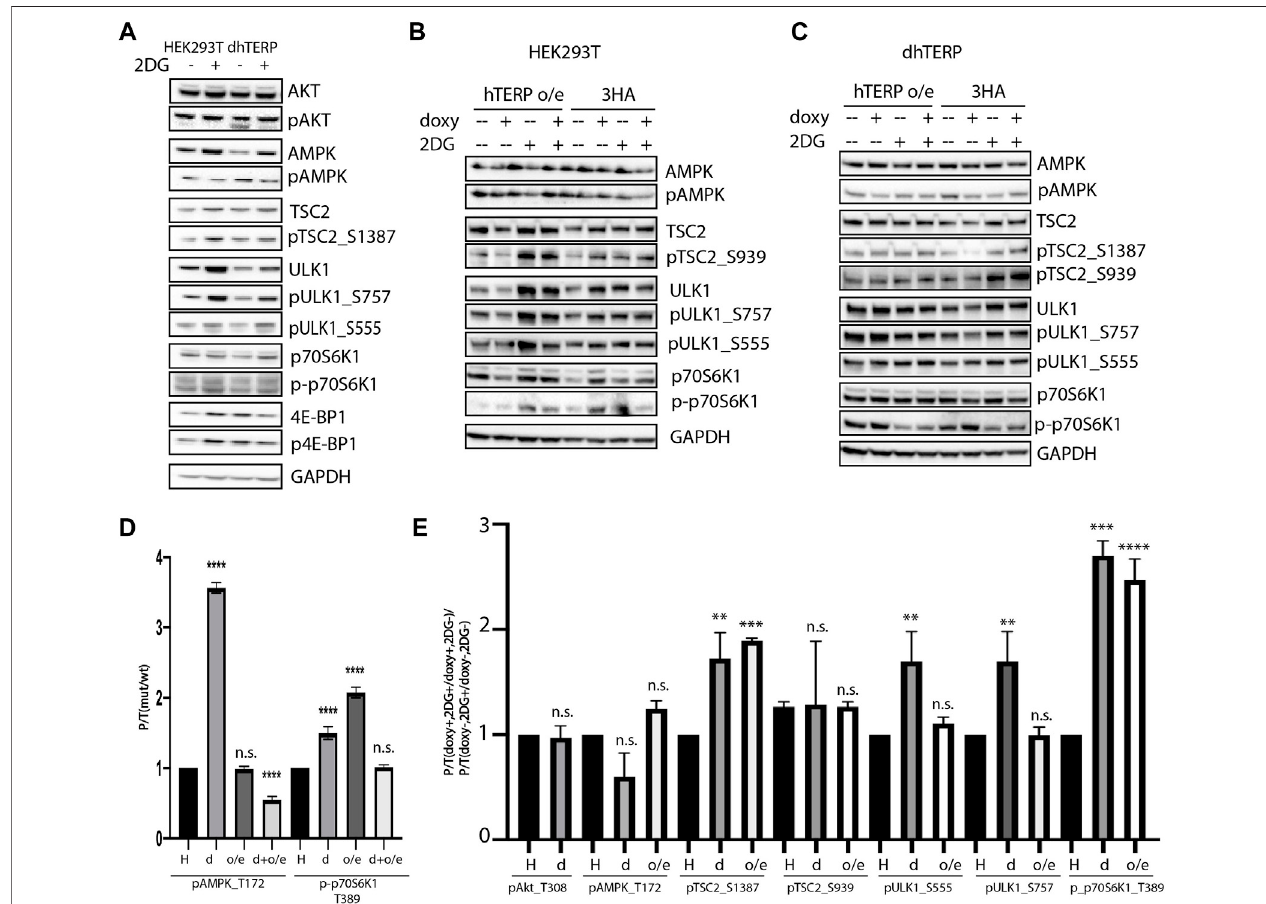
FIGURE 3 | hTERP modulates activity of kinases of relevant signaling pathways in HEK293T cells. (A) Lysates from wild-type and dhTERP HEK293T cells with or without 2 mM 2-deoxy-D-glucose (2DG) were probed with the indicated antibodies. (B,C) . Lysates prepared from wild-type HEK293T cells (B) and dhTERP HEK293T cells (C) exogenously expressing 3HA (HA) or hTERP-3HA (hTERP o/e) with or without 2 mM 2-DG were probed with the indicated antibodies. (D) Quanti fi cation of phosphorylation levels of the indicated proteins. Black bars correspond to the ratio of phosphorylated protein to total protein levels in wild-type HEK293T cells. Grey bars correspond to the ratio of phosphorylated protein to total protein level in dhTERP cells. Dark grey bars correspond to the ratio of phosphorylatedproteintototalprotein levelinoverexpressinghTERPHEK293Tcellstreatedwithdoxycycline.Lightgreybarscorrespondtotheratioofphosphorylated protein to total protein level in overexpressing hTERP dhTERP HEK293T cells treated with doxycycline. The ratio for modi fi ed cells was normalized to the ratio for wild type HEK293T cells from three independentwestern blots (mean ± SEM)and quanti fi ed using GraphPad software. **** p < 0.0001byDunett ’ smultiple comparison test. (E) Quanti fi cation of phosphorylation levels of the indicated proteins. Black bars correspond to the ratio of phosphorylated protein to total protein levels in wild-type HEK293T cells treated with 2-DG compared to that of the ratio in untreated cells. Grey bars correspond to the ratio of phosphorylated protein to total protein levels in dhTERP cells treated with 2-DG compared to that of the ratio in untreated cells. White bars correspond to the ratio of phosphorylated protein to total protein levels in overexpressing hTERP dhTERP HEK293T cells treated with doxycycline (doxy+), or 2-DG normalized to the ratio for overexpressing-3HA dhTERP HEK293T cells treatedwithdoxycycline(2DG+/doxy+),orcellsnottreatedwith2-DG(2DG − ).Thesamequanti fi cationwasperformedforsamplesnottreatedwithdoxycycline(doxy − ), or treated with 2-DG relative to the ratio of cells not treated with doxycycline (2DG+/doxy − ), or cells not treated with 2-DG (2DG − ). The normalized data were used for quanti fi cation ofchangesinthephosphorylationrateoftargeted protein upontheexogenousexpression ofhTERP [(doxy+, 2DG+/doxy+, 2DG − )/(doxy − ,2DG+/doxy − , 2DG − )]. The ratio for cells treated with 2-DG was normalized to the ratio for untreated cells from three independent western blots (mean ± SEM) and quanti fi ed using GraphPad software. ** p < 0.01, *** p < 0.001, and **** p < 0.0001 by Dunett ’ s multiple comparison test.